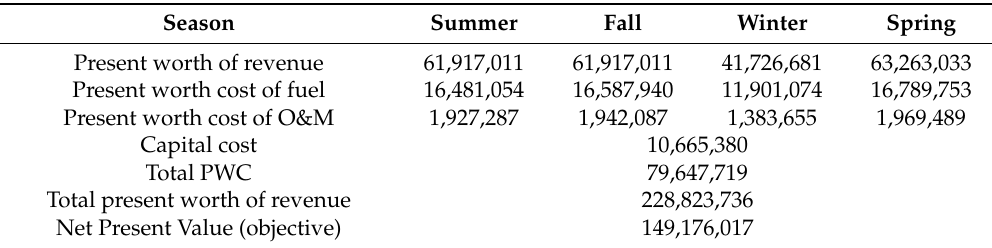
Table 29. Cost items (in € ).